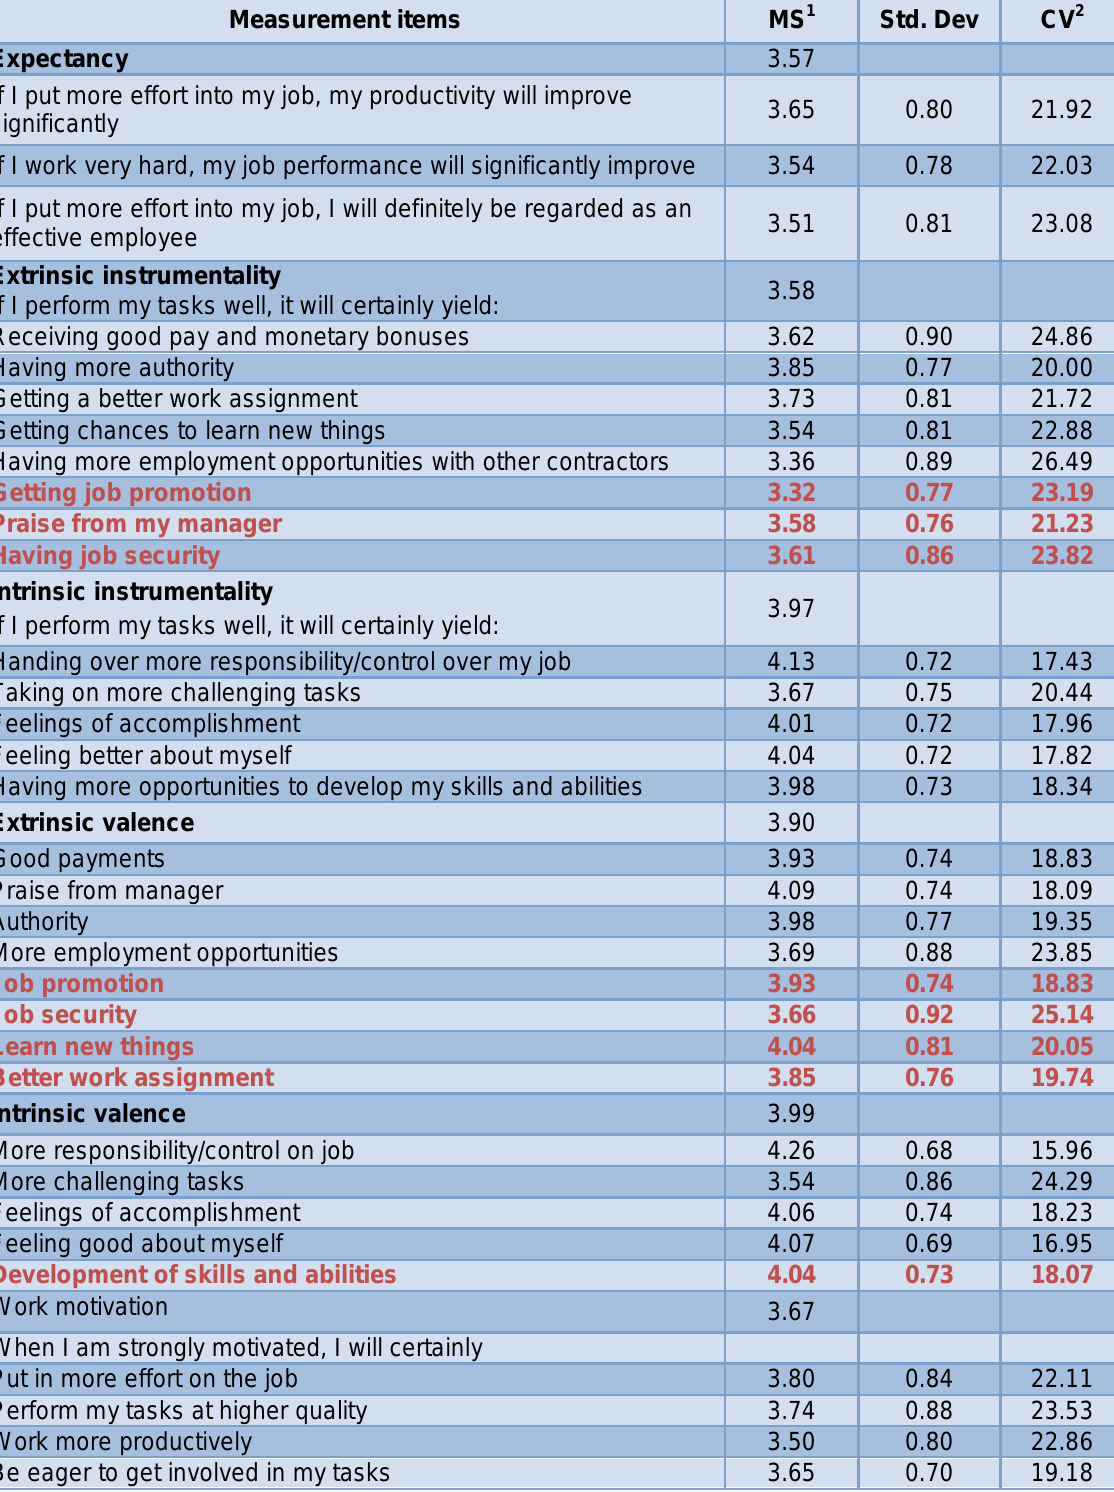
Table 1 Construction workers’ statistical responses to measurement items and constructs (original and revised